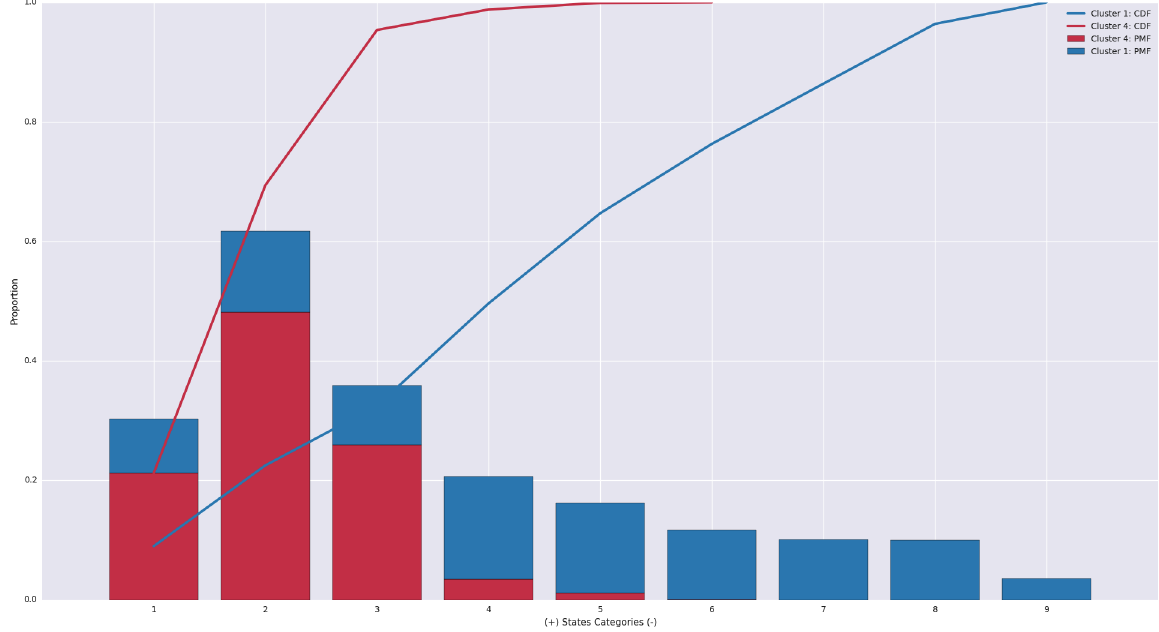
Fig 5. Stacked bars showing PMF and CDF of Clusters 1 and 4. States distributions indicate that unlike the couples in Cluster 4, Cluster 1 couples distribute affect across the range of